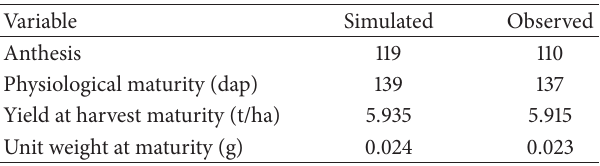
Table 3: Main growth and development variables for Basmati 370 under system of rice intensification in Mwea irrigation scheme,